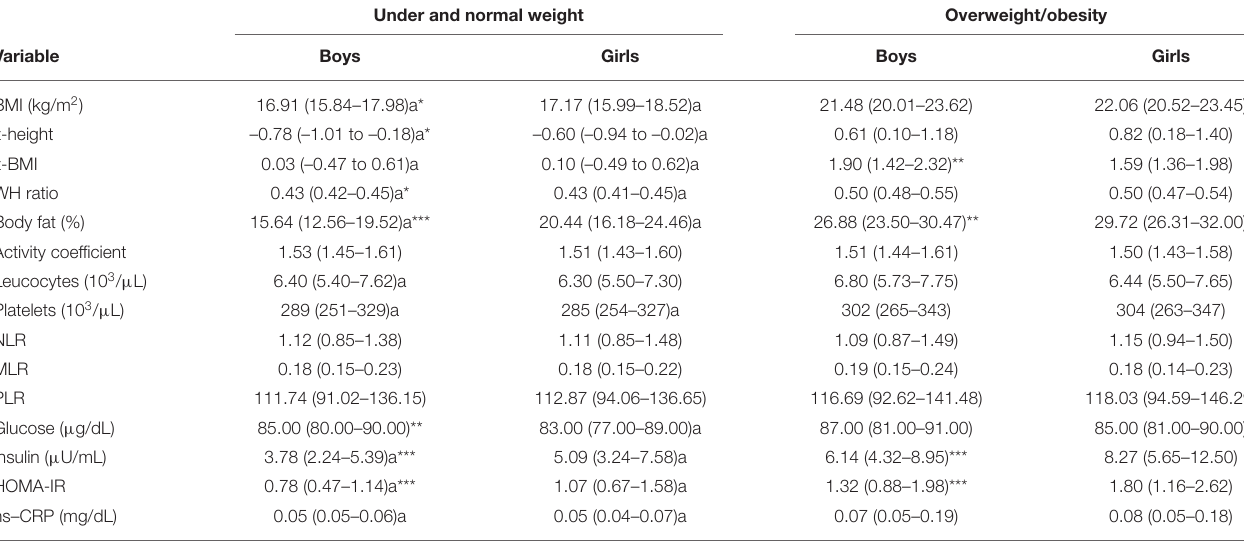
TABLE 1 | Anthropometric, blood and biochemical parameters in the schoolchildren studied according to sex and weight status. Under and normal weight